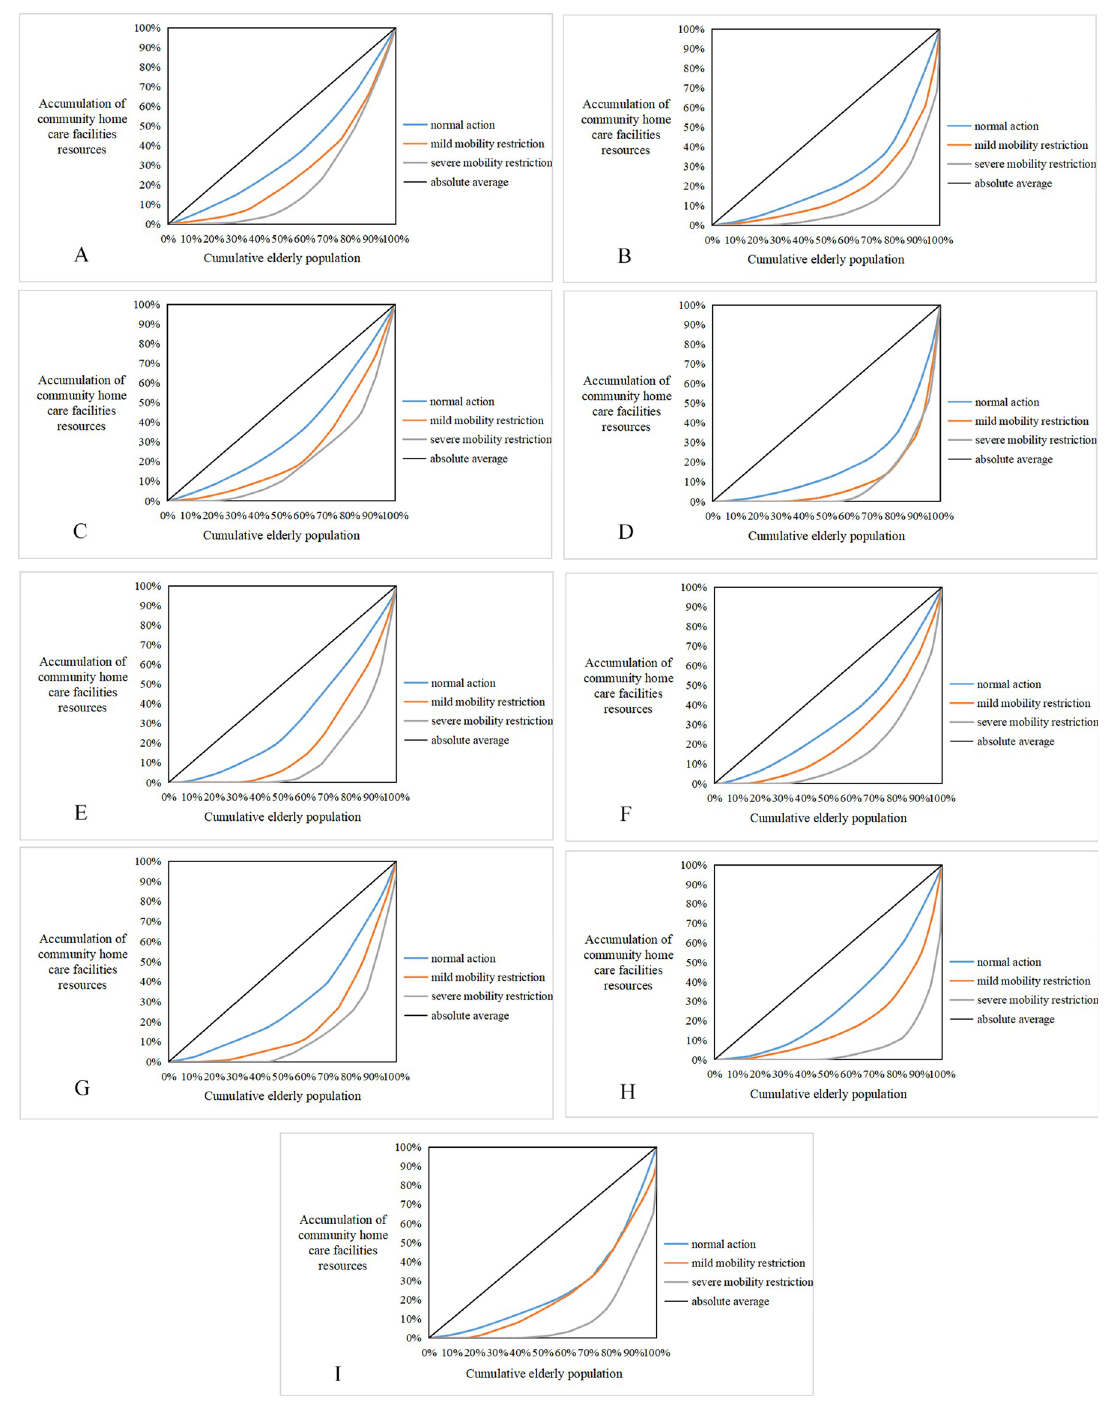
Fig 10. Lorenz curve of resource allocation of community home care services. (A) Qingnianlu Street; (B) Beiyuanmen Street; (C) Beiguan Street; (D) Hongmiaopo Street; (E) Huanchengxilu Street; (F) Xiguan Street; (G) Tumen Street; (H) Taoyuanlu Street; (I) Zaoyuan Street. (Self-drawn by the